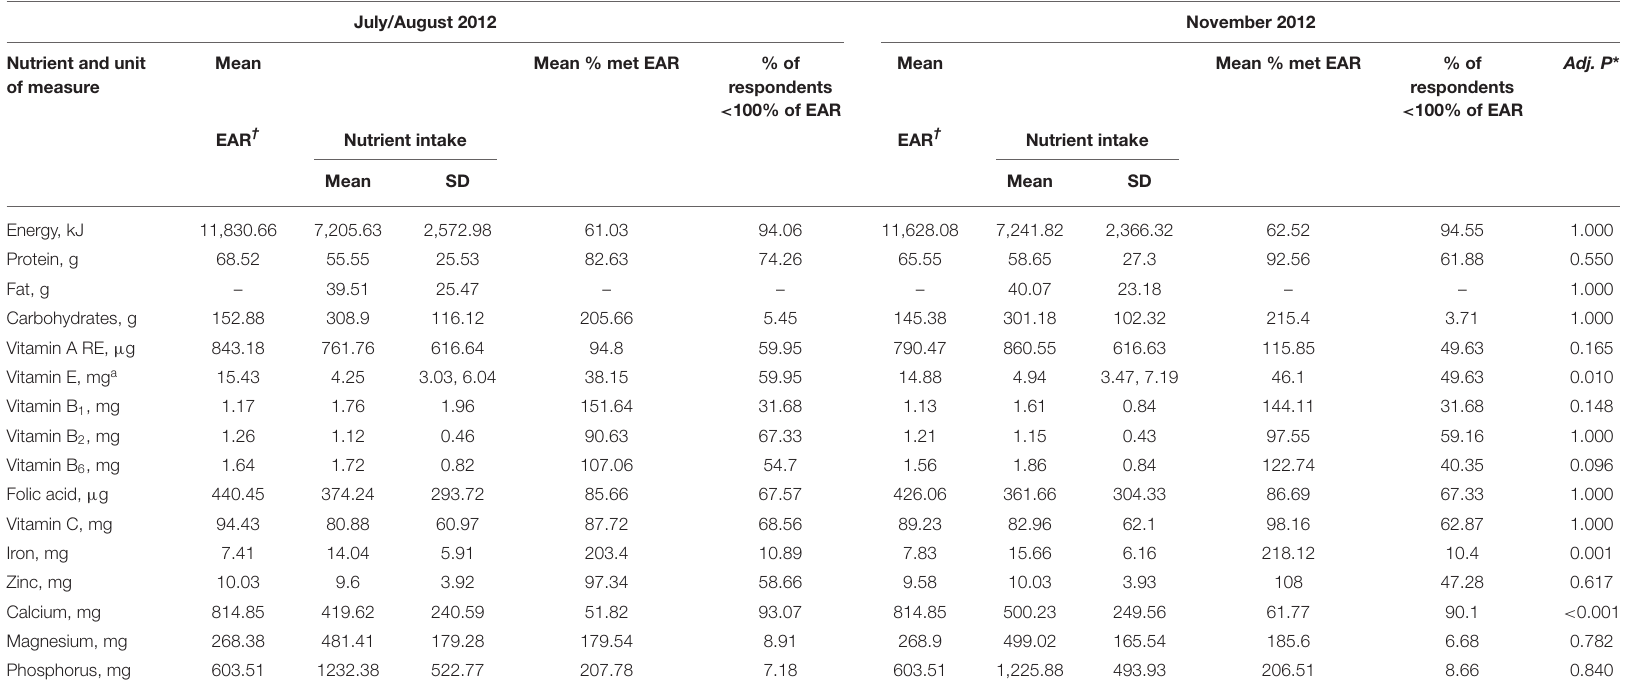
TABLE 4 | Nutrient intakes among women in July/August and November 2012 in Western Kenya ( n = 404).